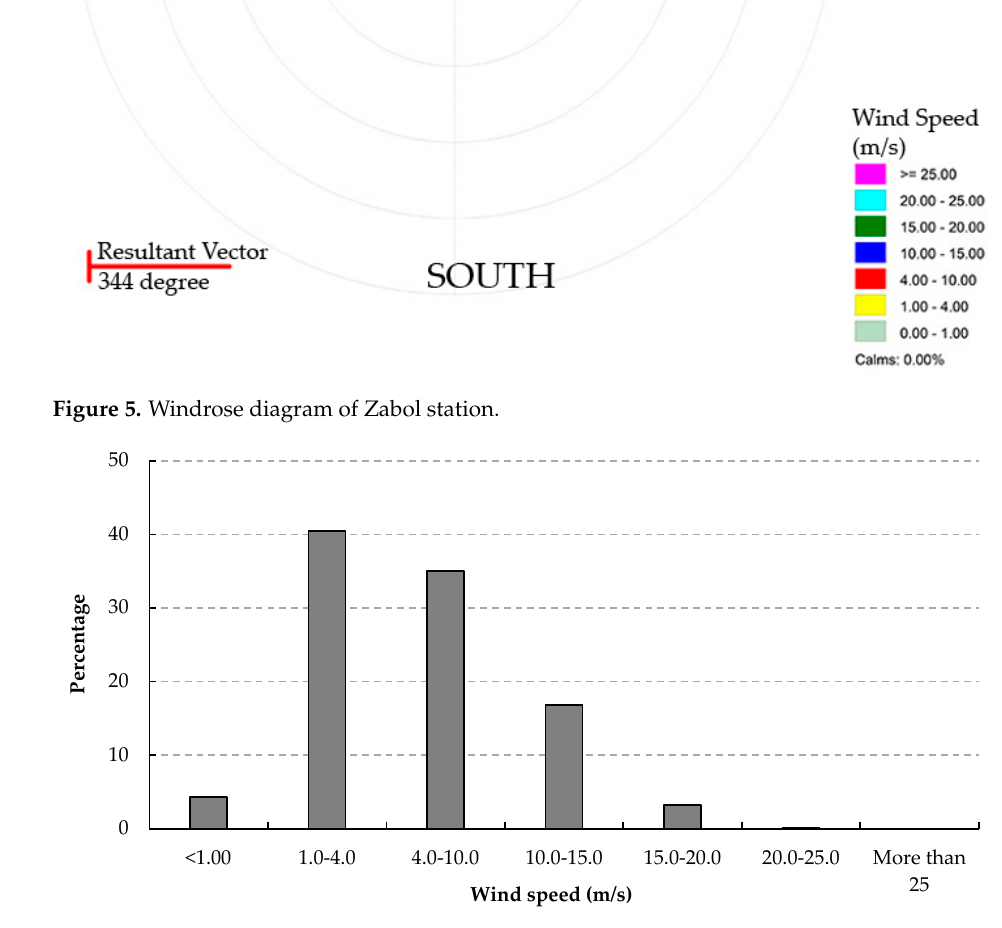
Figure 6. Wind class frequency distribution of Zabol station.